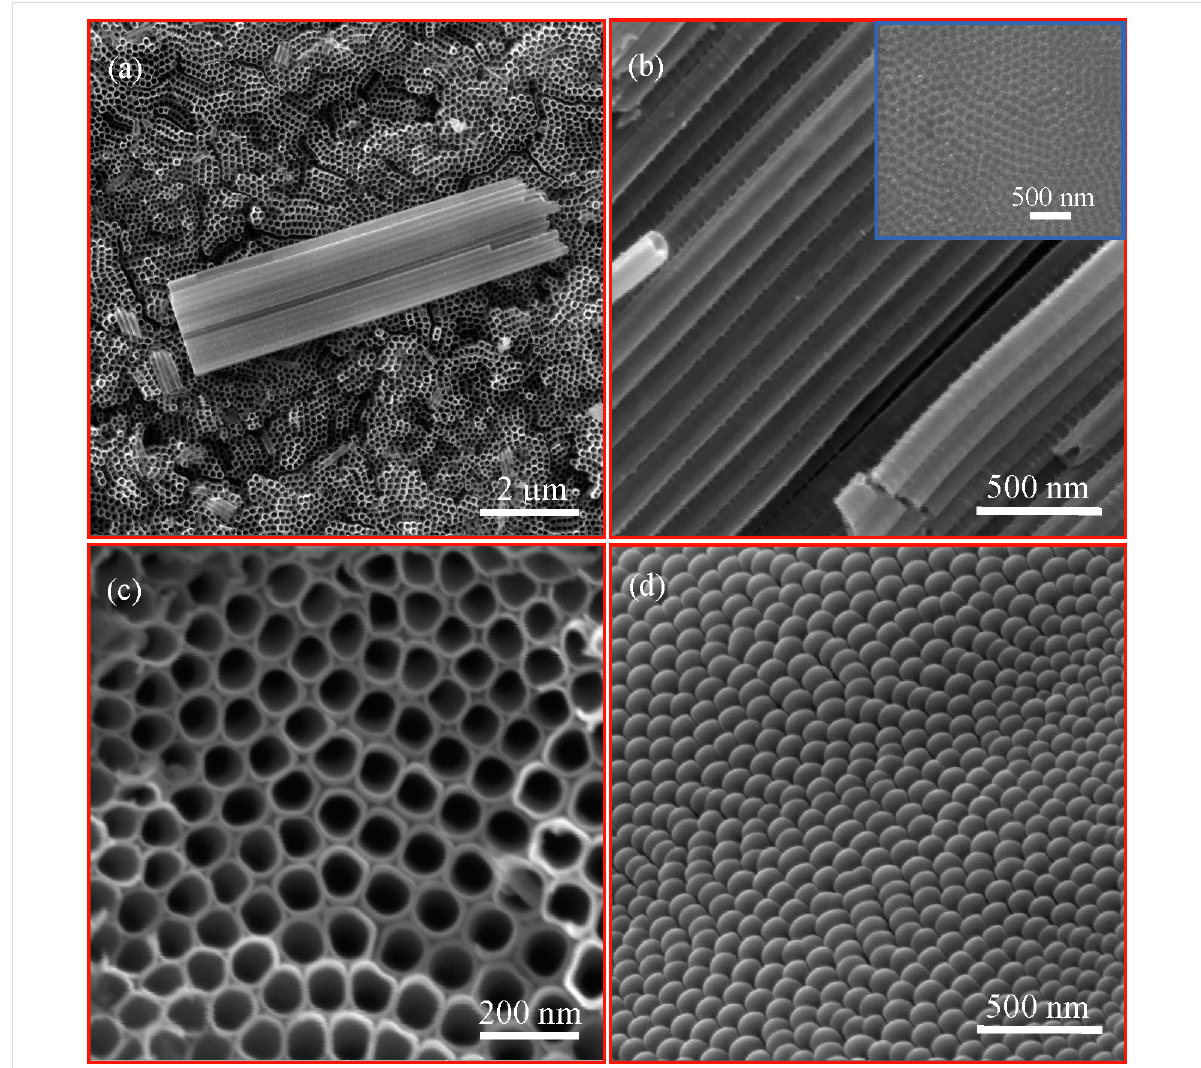
Figure 2: SEM images of the prepared pure TiO 2 nanotubes by a two-step anodization process without heat treatment; (a) overview of the TiO 2 nano- tubes with an inserted image showing the average length of about 6.5 µm of the TiO 2 nanotubes, (b) side view of the TiO 2 nanotubes with an inserted image showing well-ordered round imprints on the Ti foil after removing the TiO 2 nanotubes formed by a one-step anodization process, and (c) top view of the TiO 2 nanotubes, and (d) bottom view of the TiO 2